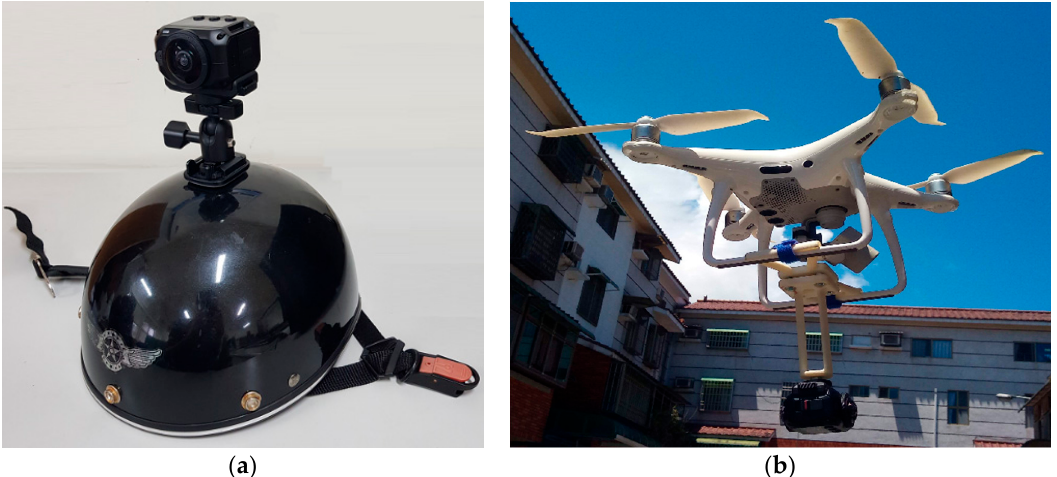
Figure 2. Two ways to set up an omnidirectional camera: ( a ) installed on top of a helmet for ground video capturing, ( b ) attached to a drone for aerial video capturing.